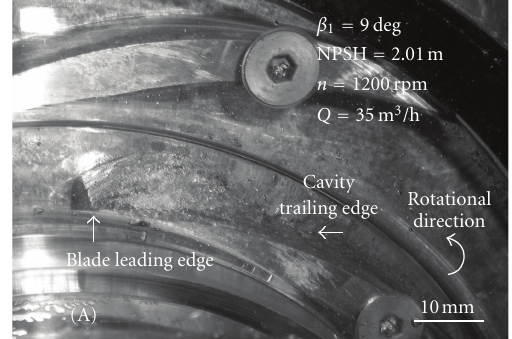
Figure 12: Illustration of cavitation for the blade leading edge angle of 9deg and NPSH equal to 2.01 m.